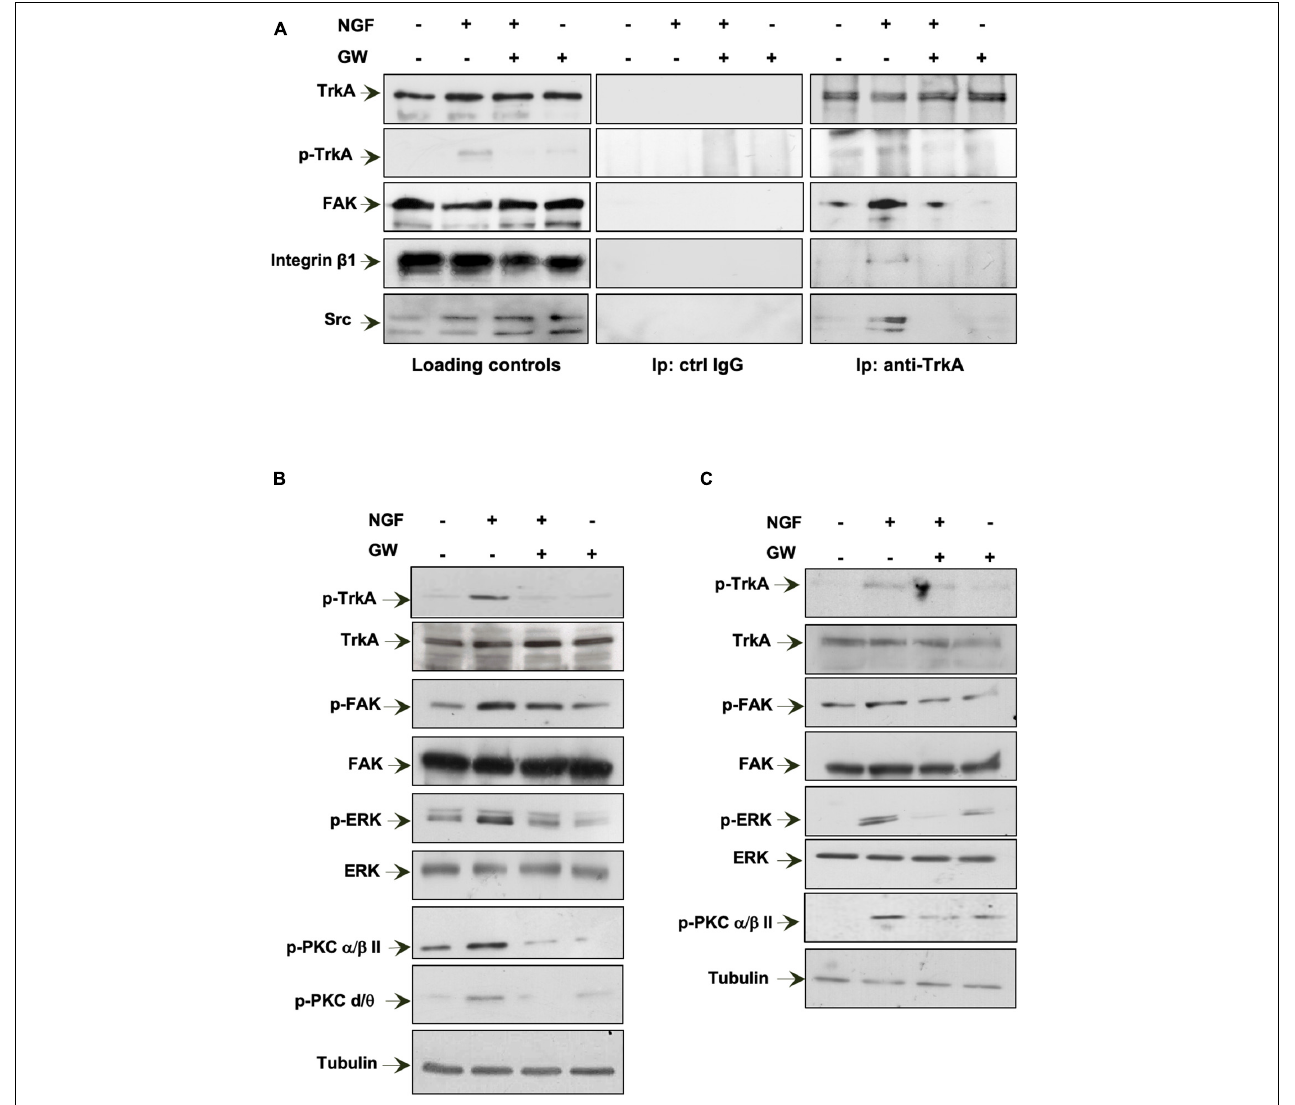
FIGURE 6 | Neurotrophin β -nerve growth factor (NGF) challenge induces the TrkA/FAK/ β 1-integrin/Src complex assembly and the NGF-dependent signaling activation. (A,B) Quiescent MDA-MB-231 cells were left unchallenged or challenged for 15 min with NGF in the absence or presence of GW441756 (GW). In (A) , lysate proteins were immunoprecipitated using the anti-TrkA antibody (anti-TrkA; right panels ) or control immunoglobulin G (ctrl IgG; middle panels ). Loading controls are shown in left panels . Western blot (WB) with the indicated antibodies was done to detect proteins in the immunocomplex. In (B) , lysate proteins were analyzed using the antibodies against the indicated proteins. (C) Quiescent MDA-MB-453 cells were left unchallenged or challenged for 15 min with NGF in the absence or presence of GW. Lysate proteins were analyzed using the antibodies against the indicated proteins. The filter was stripped and re-probed using anti-tubulin antibody as a loading control. All results are representative of three different experiments. p-TrkA , Tyr 490-p-TrkA; p-FAK , Tyr 397-p-FAK; p-ERK , p44 and p42 ERK; p-PKC α / β II , Thr 638/41-p-PKC α / β II; p-PKC δ / θ , Ser643/676.